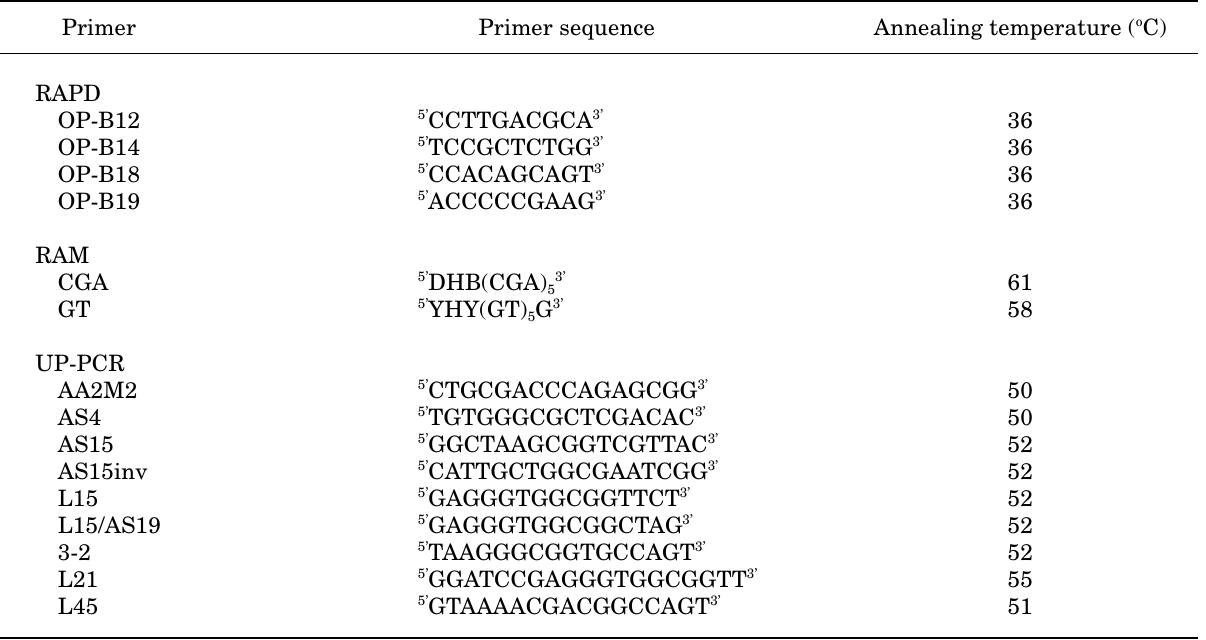
Table 2. Nucleotide sequences of RAPD, RAM, and UP-PCR primers used in this study. Primer Primer